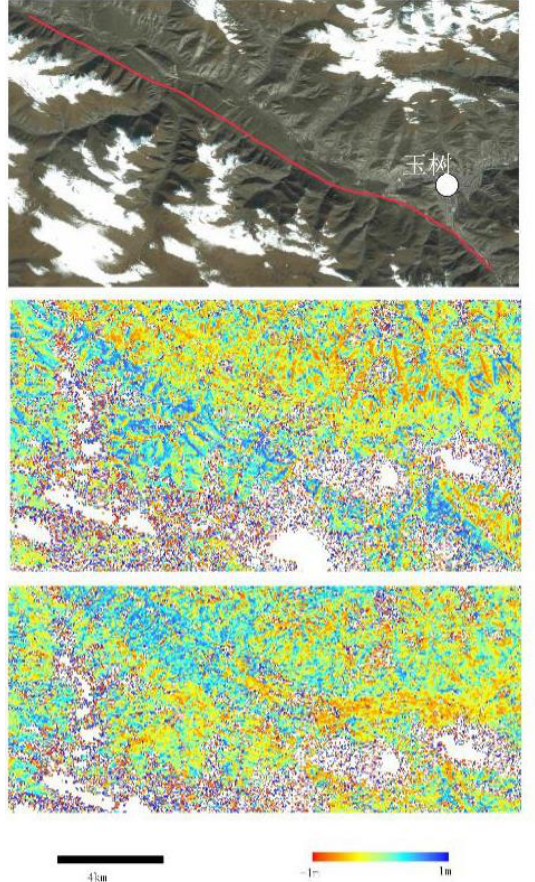
Figure 6. Co-seismic displacement field in the azimuth direction (Top subfigure: the SPOT5 satellite images before the earthquake, the red line is the co-seismic surface rupture zone. Middle subfigure: co-seismic displacement distribution in east- west direction. Bottom subfigure: co-seismic displacement distribution in north–south direction)